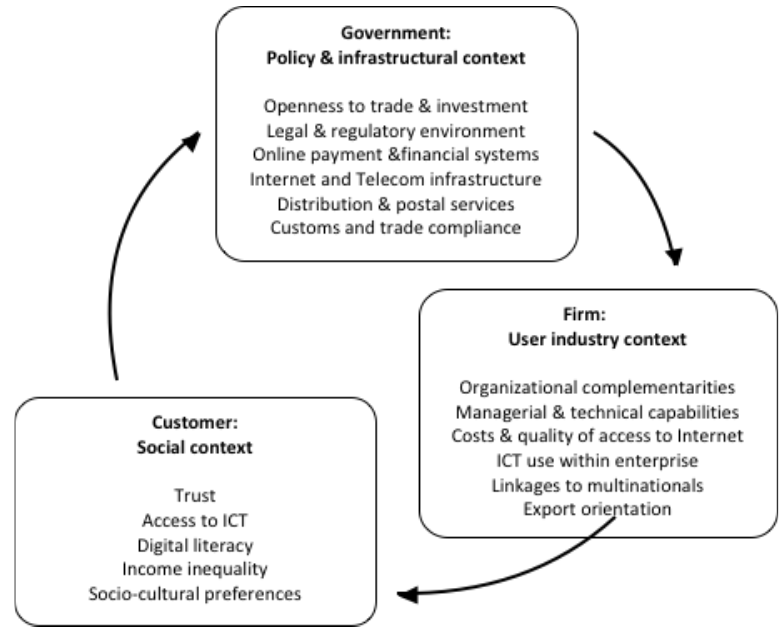
Fig 1. Factors influencing the e-commerce